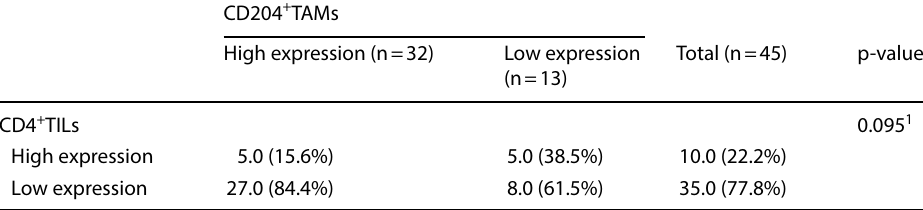
Table 4 Relationship between CD204 + TAMs and CD4 + TILs in glioblastomas